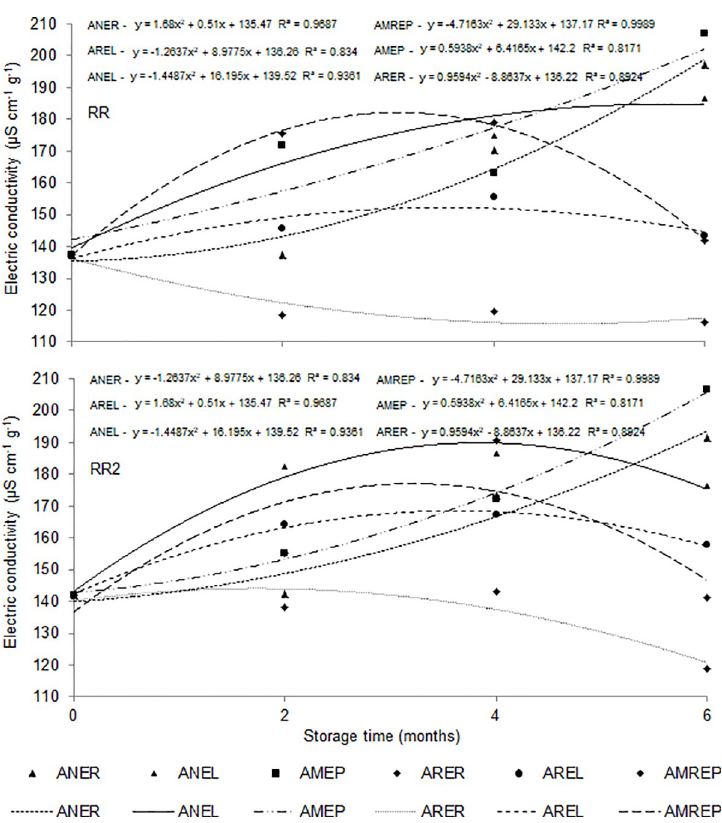
Fig 6. Electrical conductivity ( μ S cm -1 g -1 ) of soybean seeds of cultivar RR and RR2 as a function of different conditions and storage time. Ambient air + raffia packaging—ANER, Ambient air + packaging laminate packaging— ANEL, modified atmosphere (-14 PSI) + polyethylene packaging—AMEP, refrigerated atmosphere (1 to 3˚C) + raffia packaging—ARER, refrigerated atmosphere (1 to 3˚C) + laminate packaging—AREL, modified atmosphere (-14 PSI) + polyethylene packaging + refrigerated (1 to